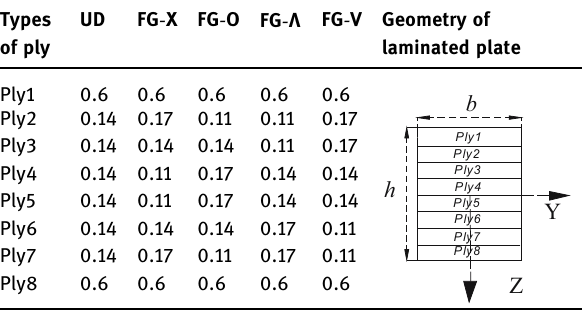
Figure 1: E ff ect of E 22 / E 11 on the EPR ( v e 1 3 ) of laminates ( 45/ − 45 ) 4S .